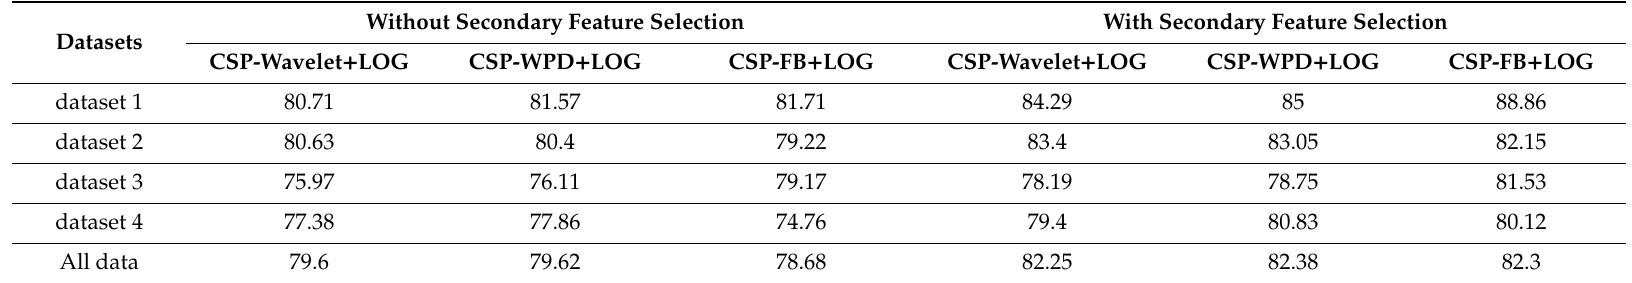
Table 7. The e ff ect of secondary feature selection on average classification accuracy of various datasets (the LOG